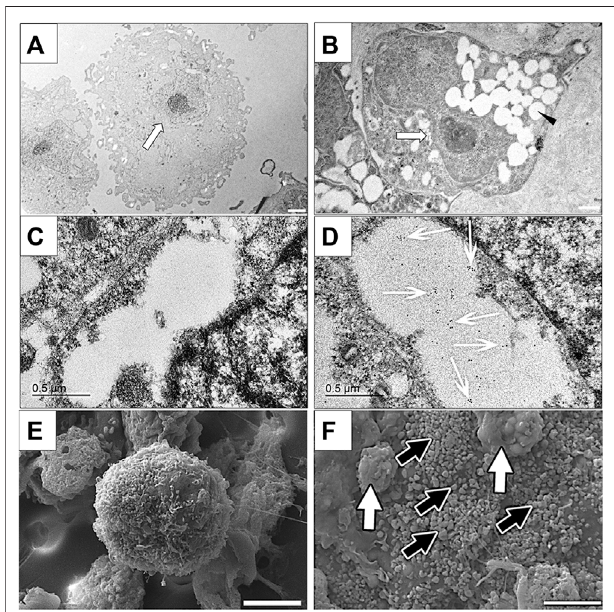
FIGURE 8 | Transmission electron photomicrographs (A,B) , immunoelectron photomicrographs (C,D) and scanning electron photomicrographs of cells in feline ASC clusters following three stages of cultureinstromal (A,C,E) ordifferentiation (B,D,F) medium.Nuclei[ (A,B) whitearrow] and vacuoles[ (B) , black arrowhead],gold-labeledinsulinwithina vacuole [ (D) , white arrows], and individual [black arrows, (F) ] and clumped [whitearrows, (F) ]surfacegranulesareindicated.Scalebars=2 μ m (A) ,1 μ m (B) , 0.5 μ m (C,D) , and 5 μ m (E,F) .